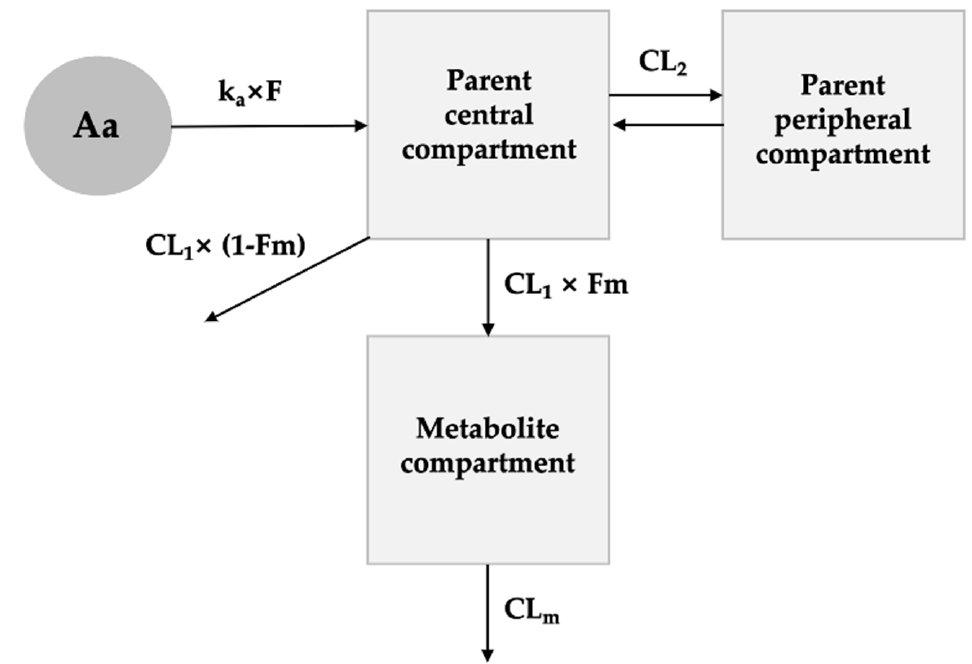
Figure 5. Parent-metabolite PK model scheme for FMN and DZN following the oral administration of FMN solid dispersion. (CL: clearance of FMN; CL m , clearance of DZN, k a : absorption rate constant; F, fraction of FMN absorbed; Fm, fraction of FMN metabolized). Table 5. The parent-metabolite PK model development process for FMN and DZN after oral ad- ministration of 20 mg/kg FMN solid dispersion.